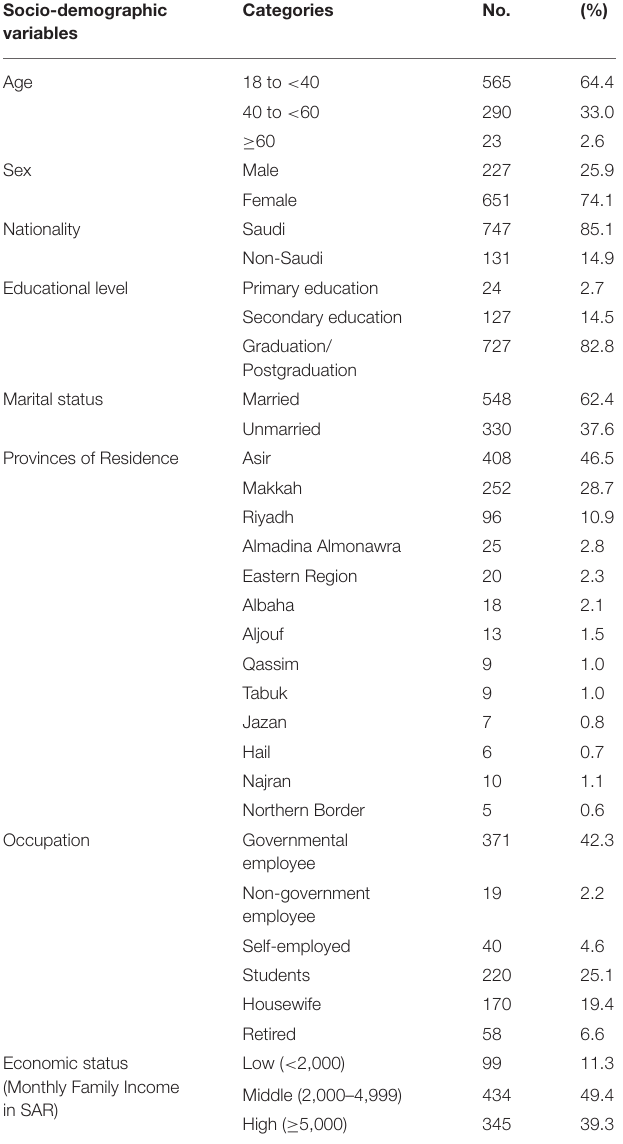
TABLE 2 | Health profile, COVID-19 cases contact, and medical field association among the studied participants ( N = 878).